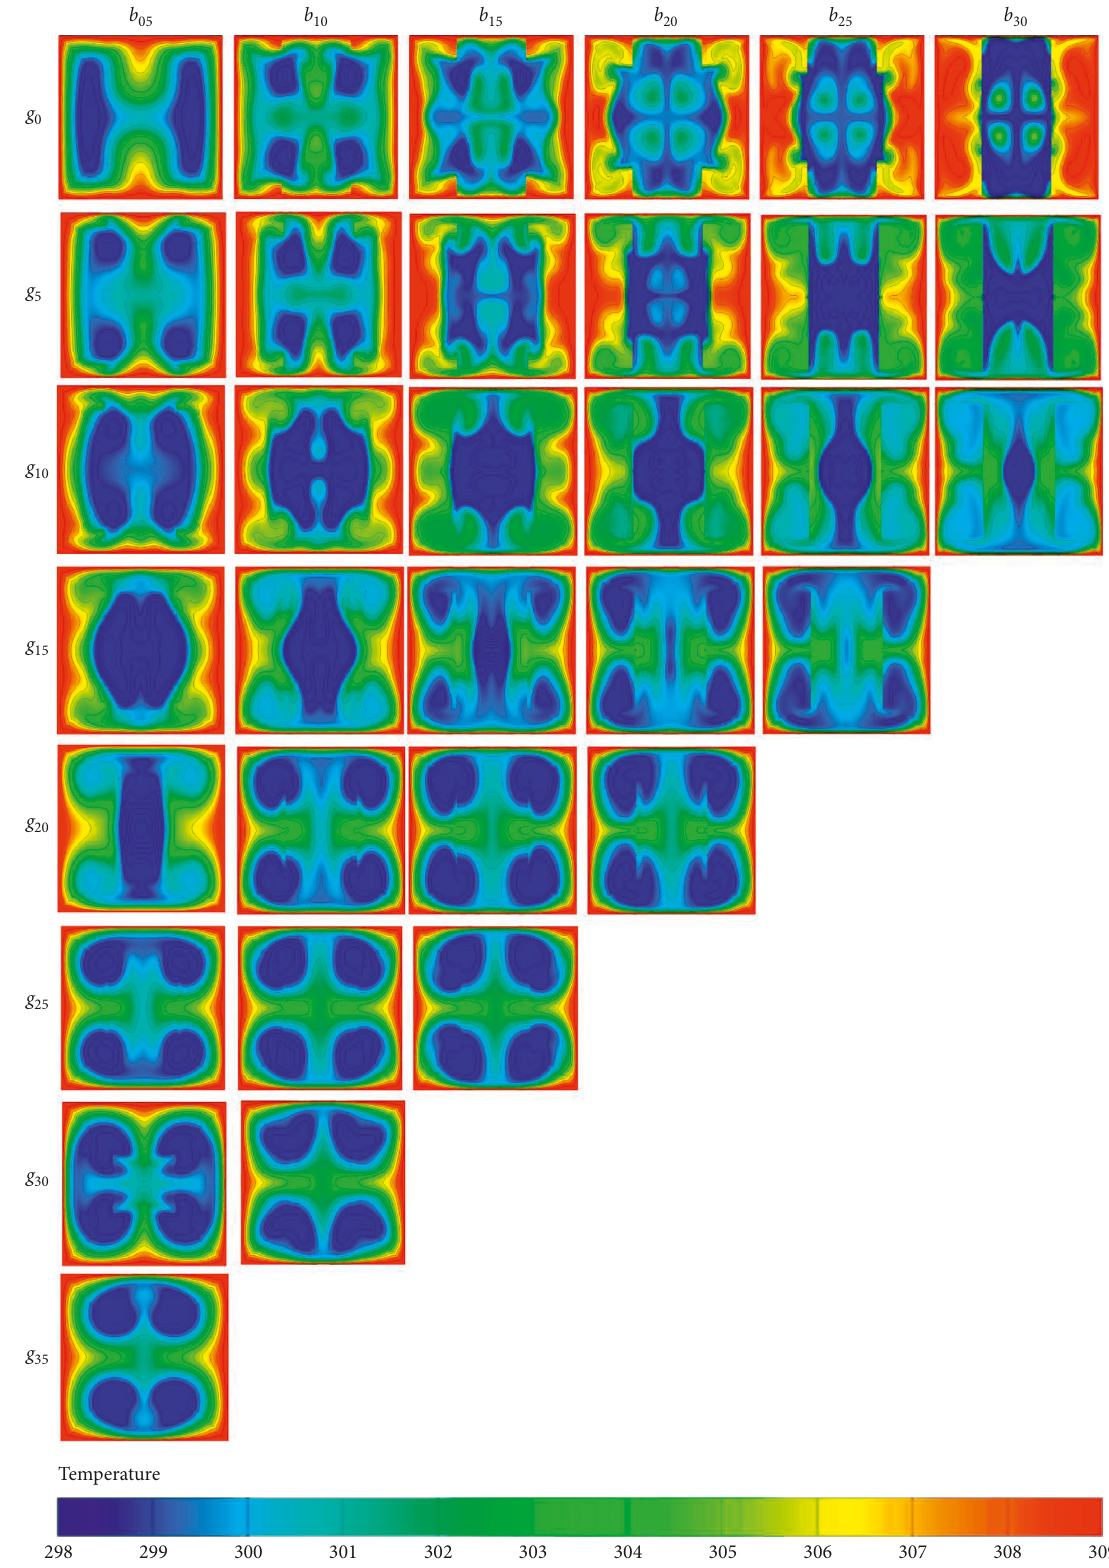
Figure 5: Temperature distribution in transverse planes for the square channel heat exchanger installed with V-orifice at various blockage ratios and gap spacing ratios for Re 800 and V-downstream (cid:31)